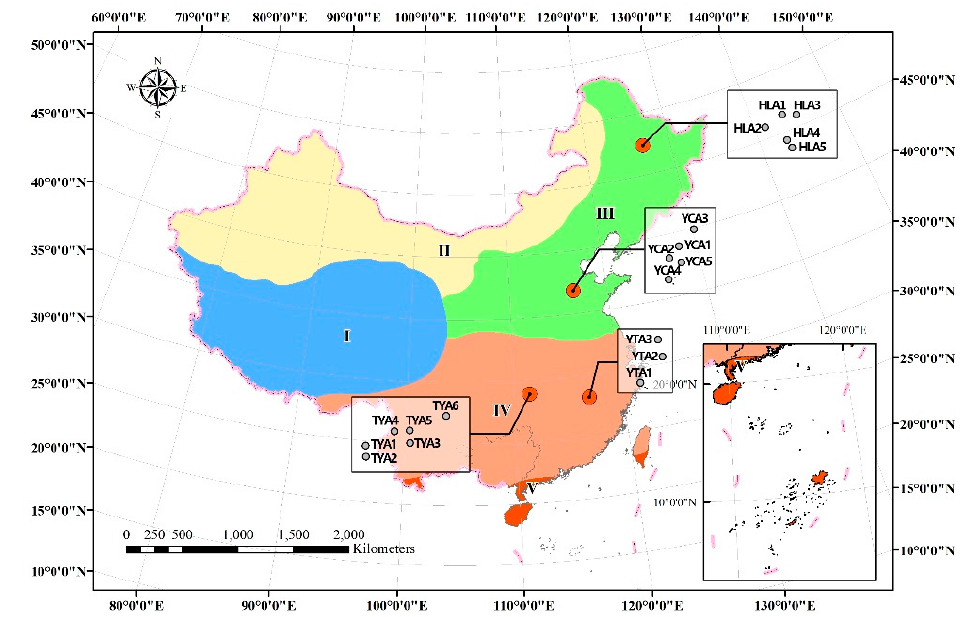
Figure 2. Map of sampling sites in this study. Sampling sites are labeled with red circles and sampling plot names are labeled around sites. The map presents the distribution of five climate zones namely region I to region V, representing the plateau and mountain climate zone, temperate continental climate zone, temperate monsoon climate zone, subtropical monsoon climate zone and tropical monsoon climate zone, respectively.